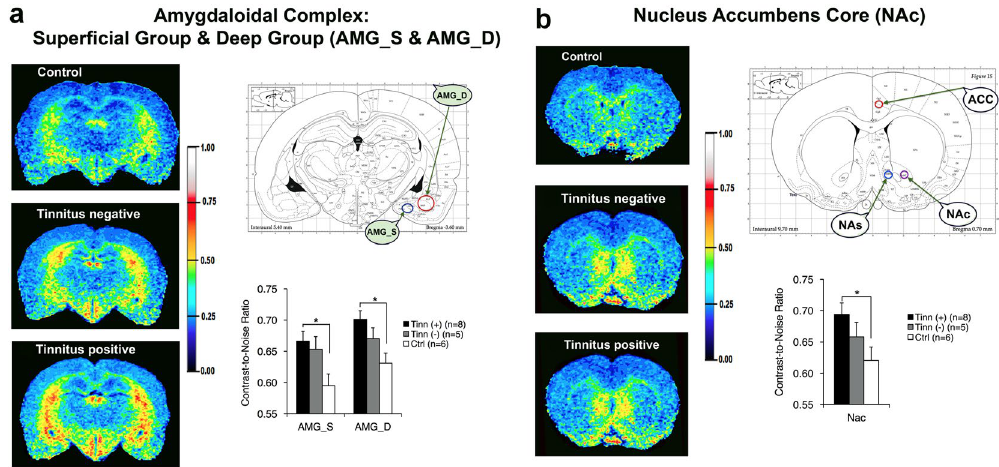
Figure 4. Blast-induced tinnitus ( + ) rats had higher neural activity in two amygdala subdivisions and in the nucleus accumbens core (NAc) compared to control (ctrl) rats, though there were no significant differences between tinnitus ( + ) and tinnitus ( − ) rats. Images were color-coded according to manganese uptake intensity, as defined by the color scale-bar. Color-coded images are shown for a representative tinnitus( + ), tinnitus( − ) and control (ctrl) rat. A rat brain atlas was used to guide ROI placement. The bar graphs indicate the averaged uptake values per group and brain region. ( a ) Significantly higher manganese uptake was observed in the superficial and deep amygdalae (AMG S and AMG D ) of the tinnitus( + ) group, compared to the control group, as well as in the ( b ) nucleus accumbens core regions (NA C ). * Indicates statistical significance (p < 0.05). Atlases were adapted from The Rat Brain In Sterotaxic Coordinates, 4 th Edition by Paxinos and Watson (1998) with permission from the